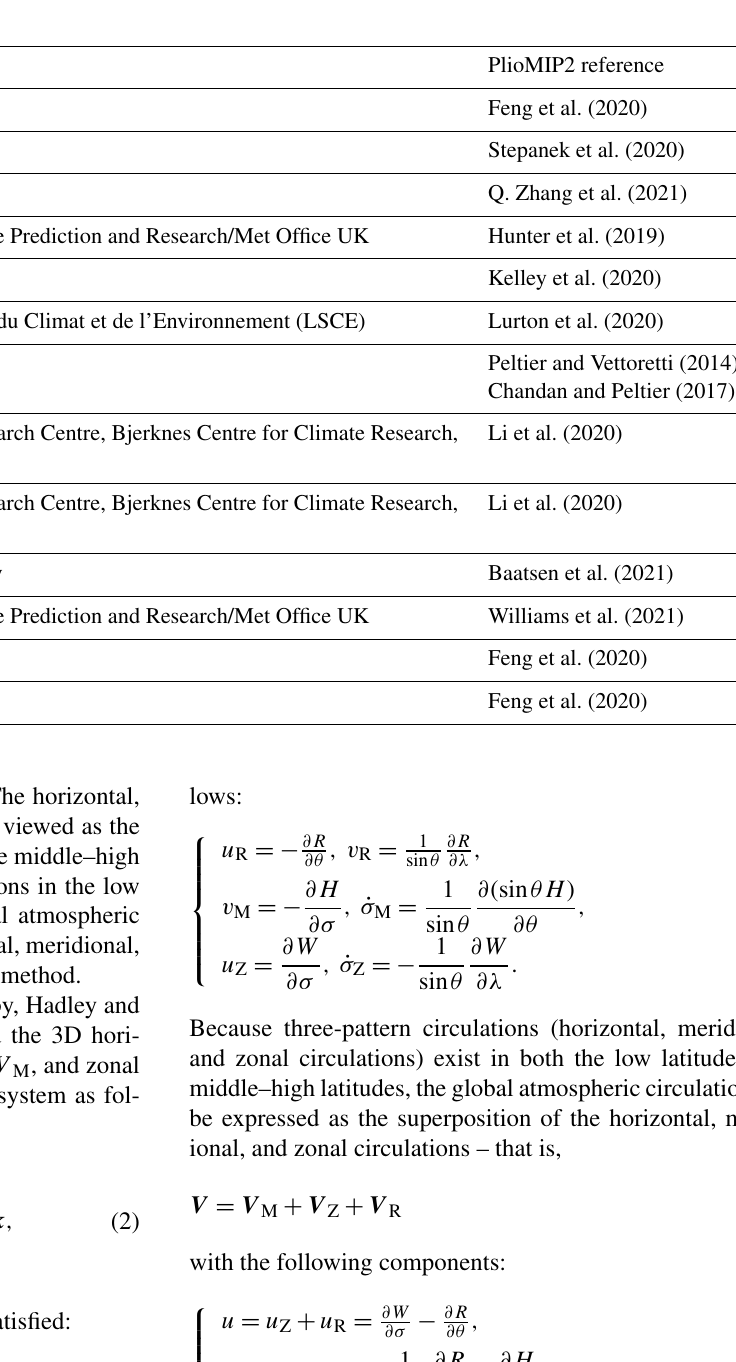
Table 1. PlioMIP2 models used in this